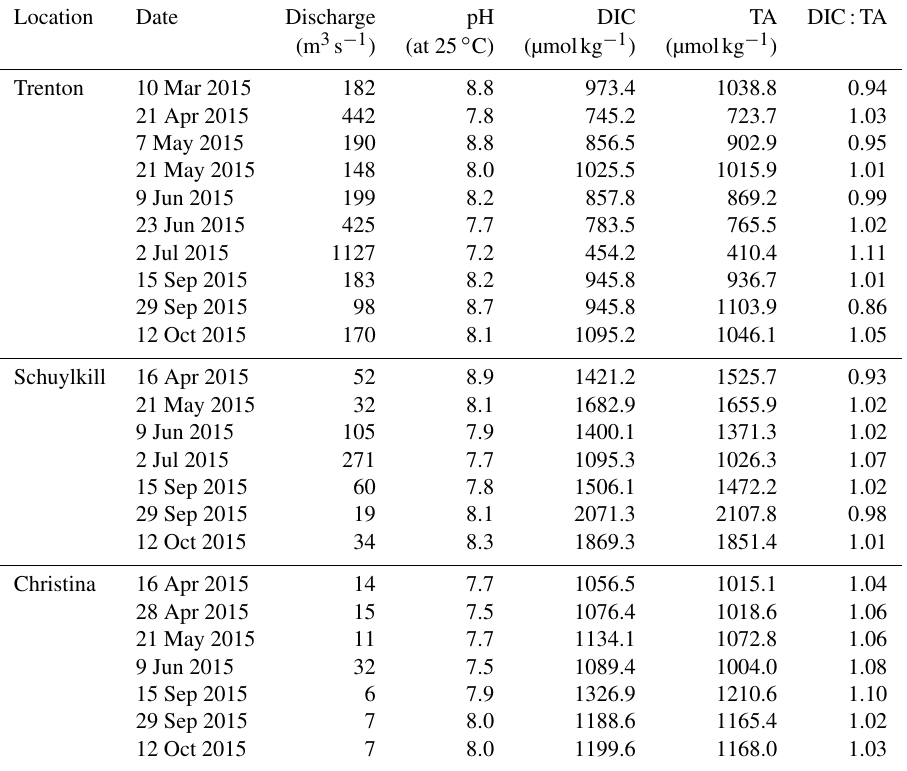
Table 1. Sampling dates, average discharge, pH, DIC, TA, and DIC-to-TA ratio in the Delaware (Trenton), Schuylkill, and Christina rivers.